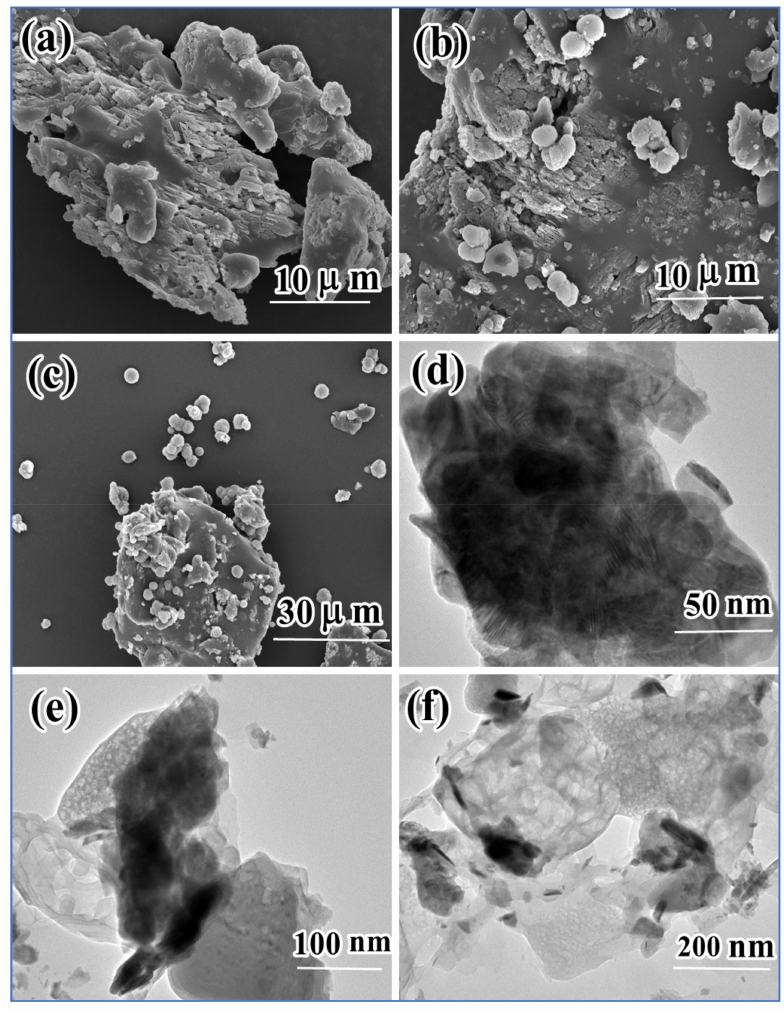
Figure 2. SEM images of ( a ) GA-cl-poly(acrylamide)@C 3 N4; ( b , c ) GA-cl-poly(acrylamide)@C 3 N 4 /BiOI nanocomposite hydrogel and ( d – f ) TEM images of GA-cl-poly(acrylamide)@ C 3 N 4 /BiOI nanocom- posite